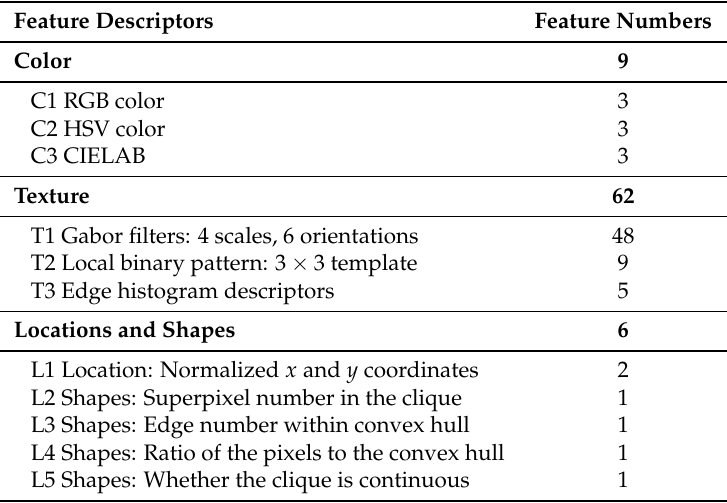
Table 2. Feature descriptors of superpixels (superpixel cliques).